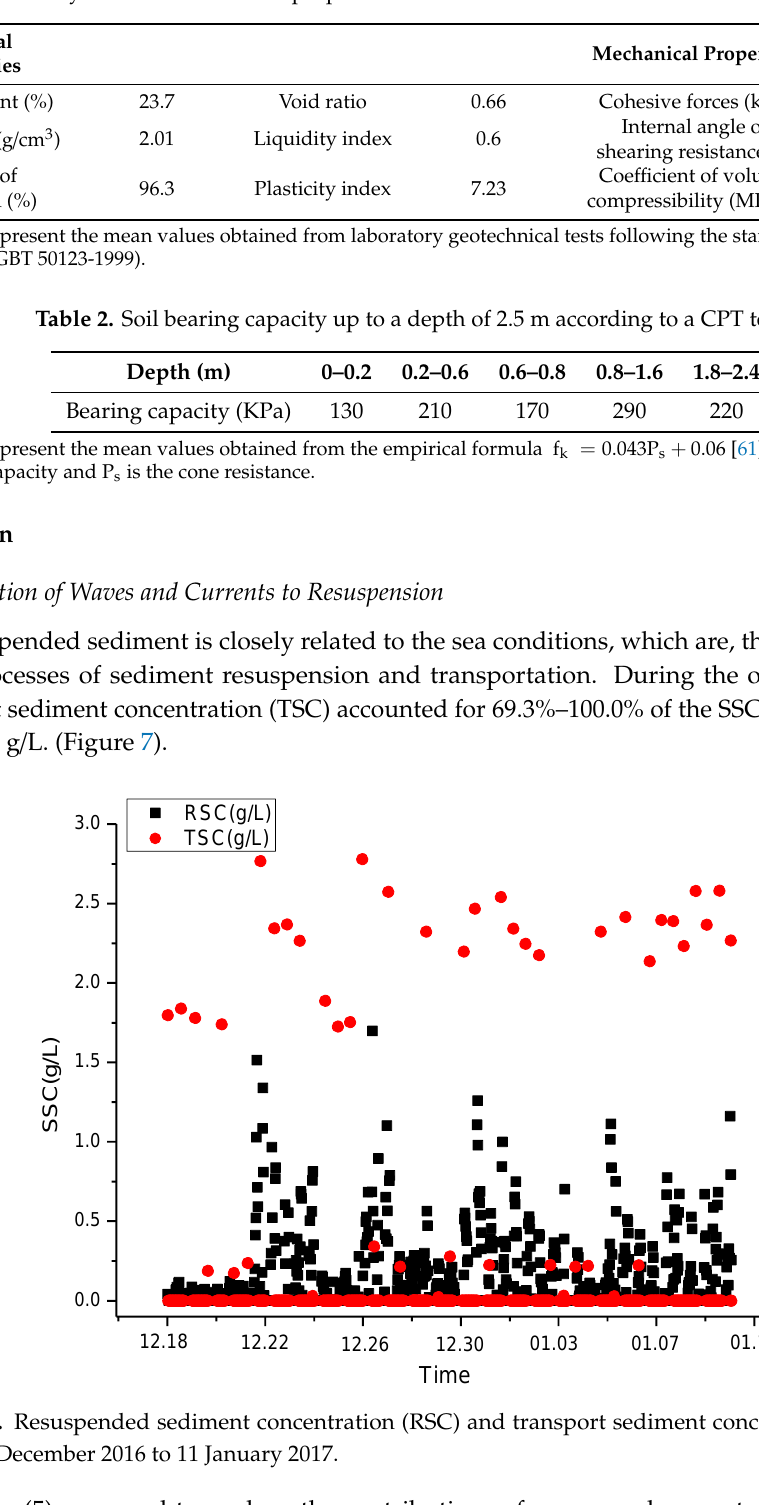
Table 1. Physical and mechanical properties of seabed soils collected in a 5 m sediment core.